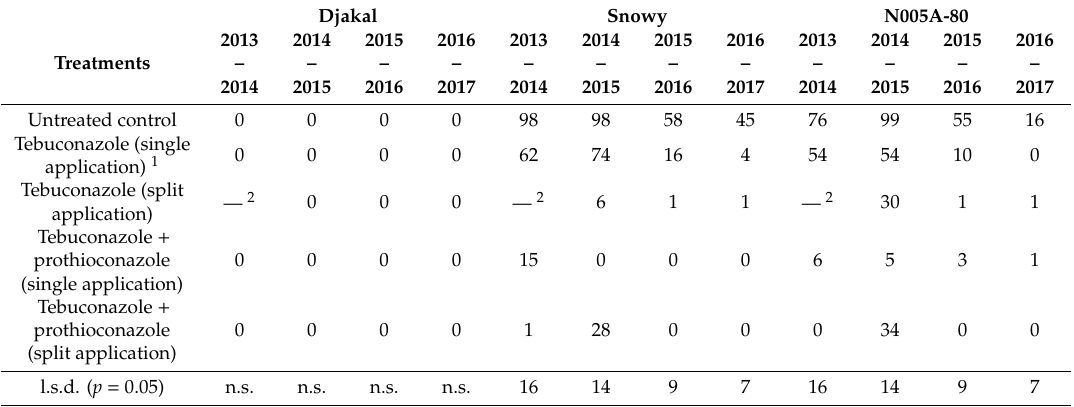
Table 2. Fungicide treatment e ff ects on powdery mildew infection severity (%) during growth stage R7 for three cultivars in four years of field experiments at Leeton Field Station, New South Wales. Djakal Snowy